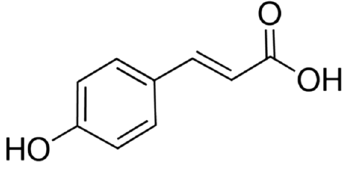
Fig. 17 Structure of galangin (3,5,7-trihrdroxyflavone) Fig. 18 Structure of p-coumaric acid